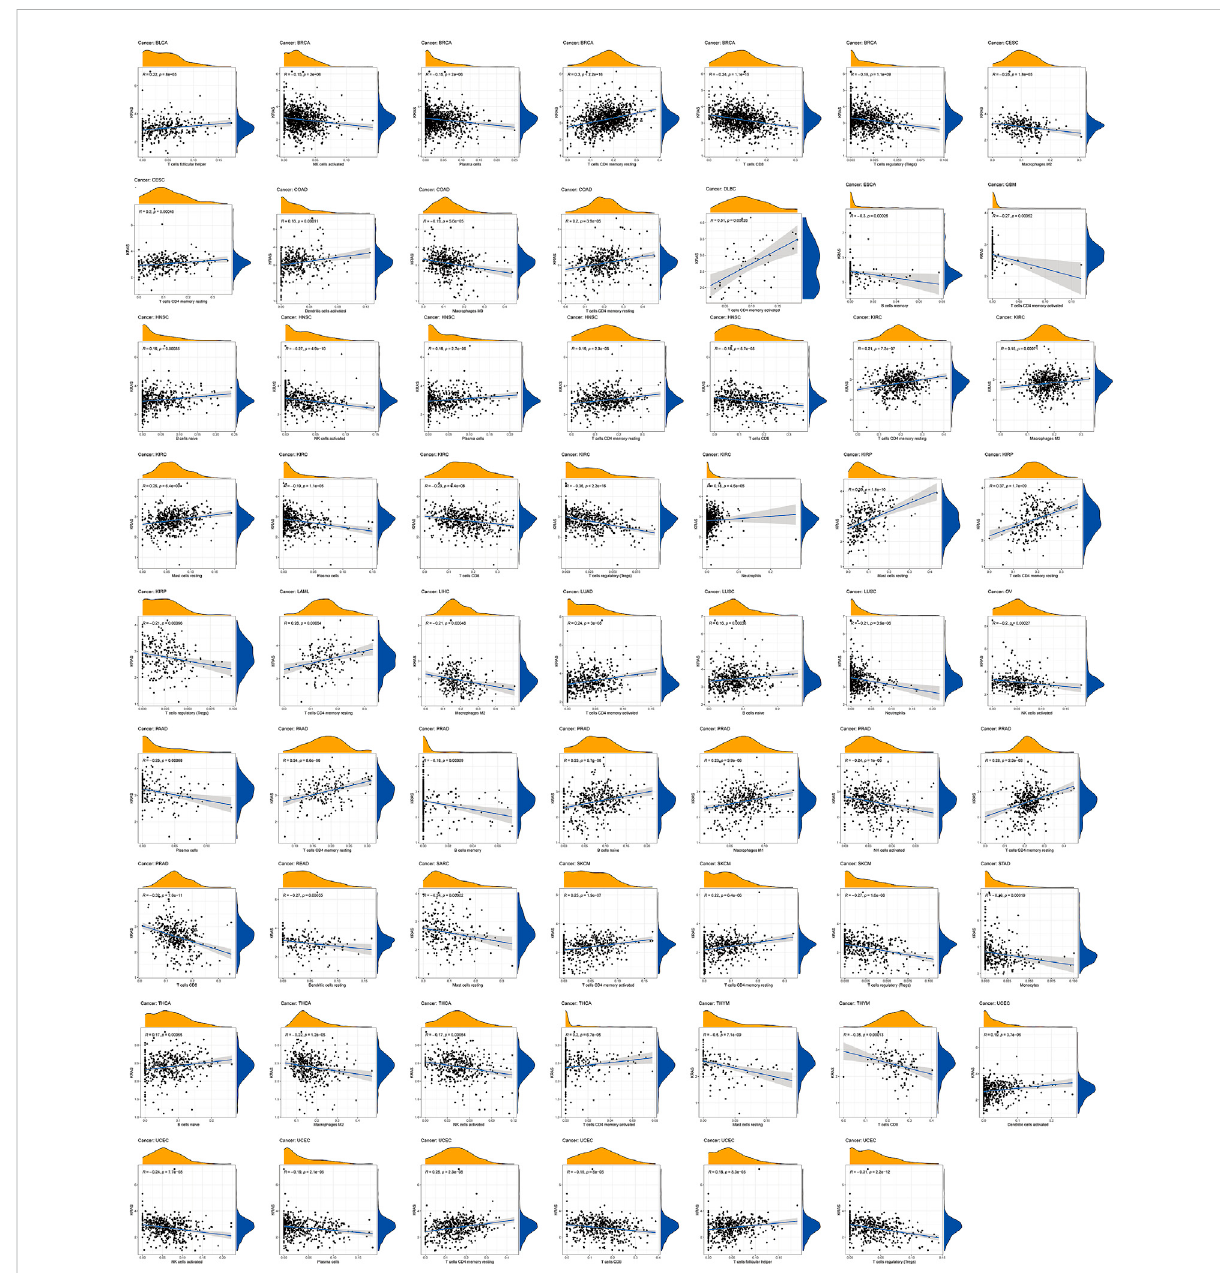
FIGURE 5 Relationships between KRAS expression and different types of immune cells in fi ltration level in